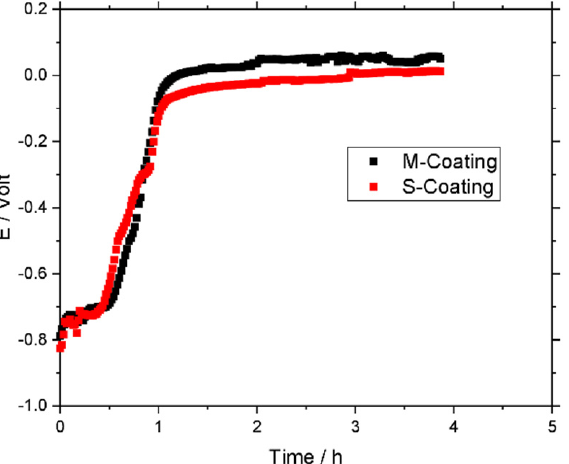
Figure 1. OCP-time profiles recorded during the formation of M-coating and S-coating samples in molten carbonate salt baths at 580 °C, under a CO 2 gas bubbling atmosphere. Substrate: K41 ferritic stainless steel.